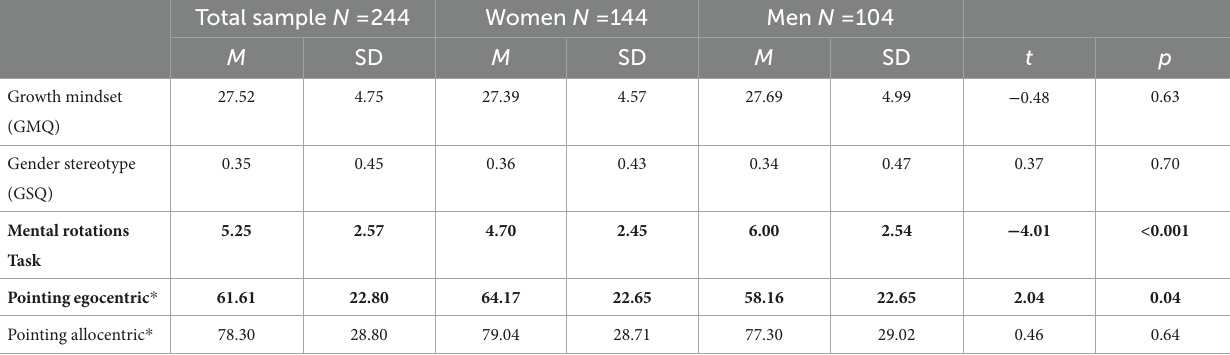
TABLE 1 Descriptive statistics of total sample, and divided for men and